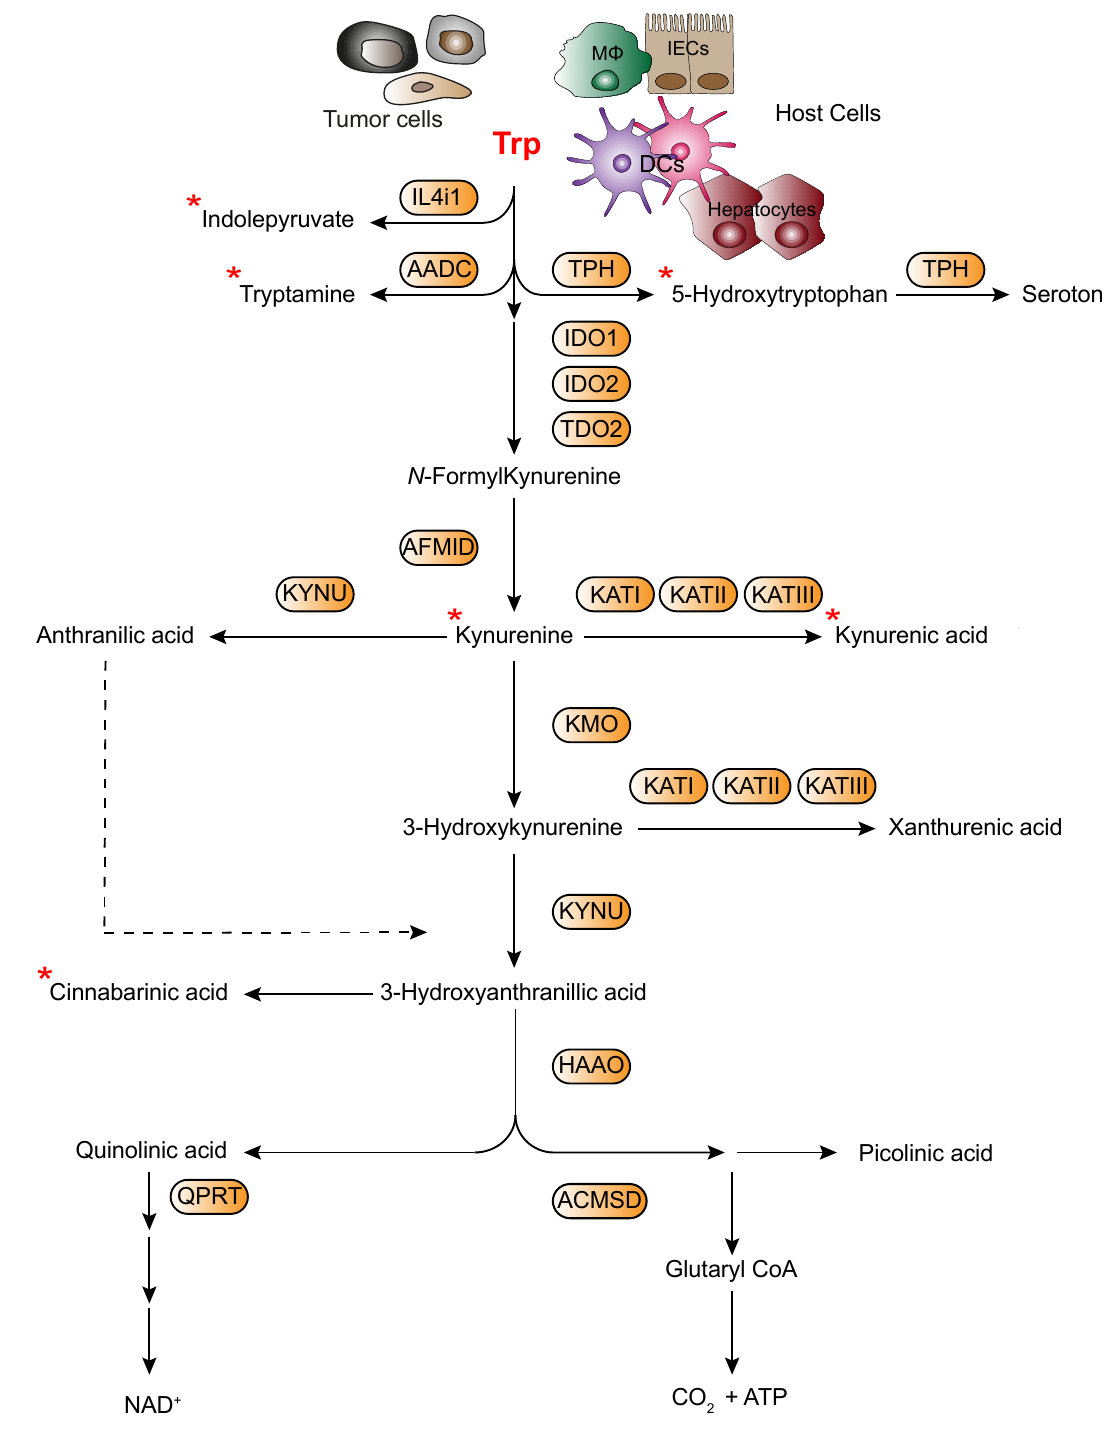
Figure 2. Main routes of tryptophan metabolism in host’s cells. AADC, aromatic-l-amino acid decarboxylase, TPH, tryptophan hydroxylase, IDO1, indoleamine-2,3-dioxygenase 1, IDO2, indoleamine-2,3-dioxygenase2, TDO, tryptophan-2,3-dioxygenase, AFMID, kynurenine formamidase, KATs, kynurenine amino transferases I–III, KMO, kynurenine 3-monooxygenase, KYNU, kynureninase, HAAO, 3-hydroxyanthranilate 3,4-dioxygenase, ACMSD, α -amino- β - carboxymuconate- ε - semialdehyde decarboxylase, QPRT, quinolinic acid phosphoribosyl transferase. * Indicates known AhR